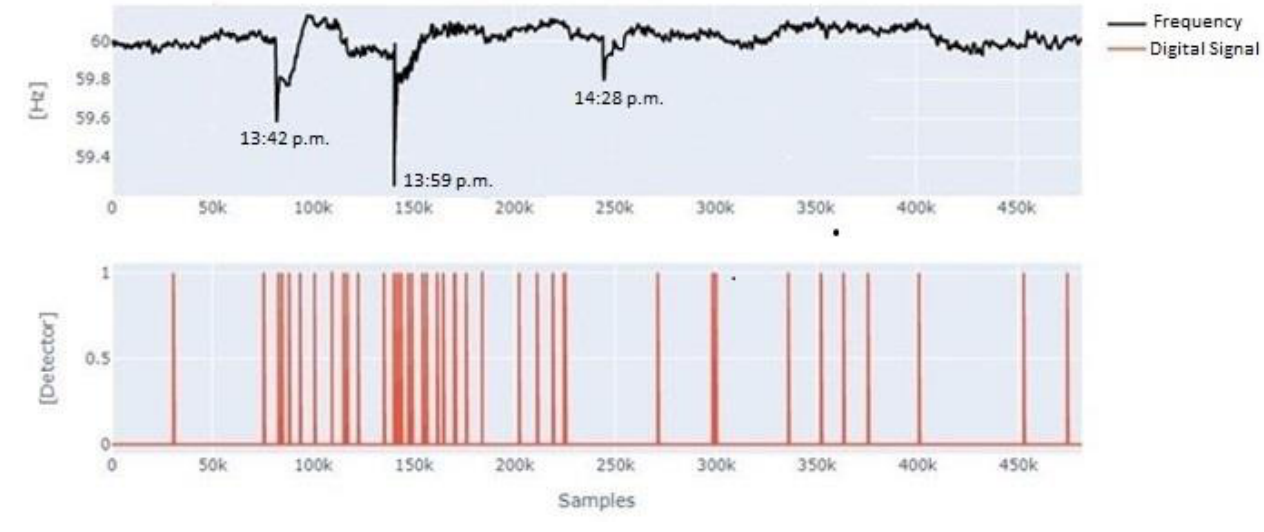
Figure 23. Event 2: final detector.